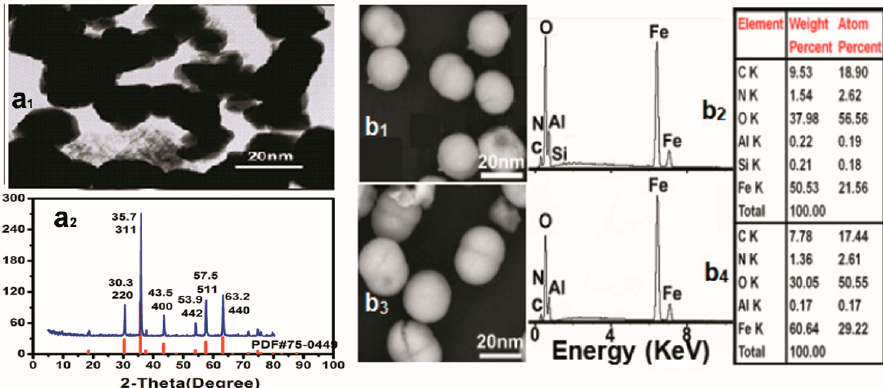
Figure 3. ( a 1 ) TEM images and ( a 2 ) XRD patterns of Fe 3 O 4 -MNPs sample as well as ( b 1 ) SEM images